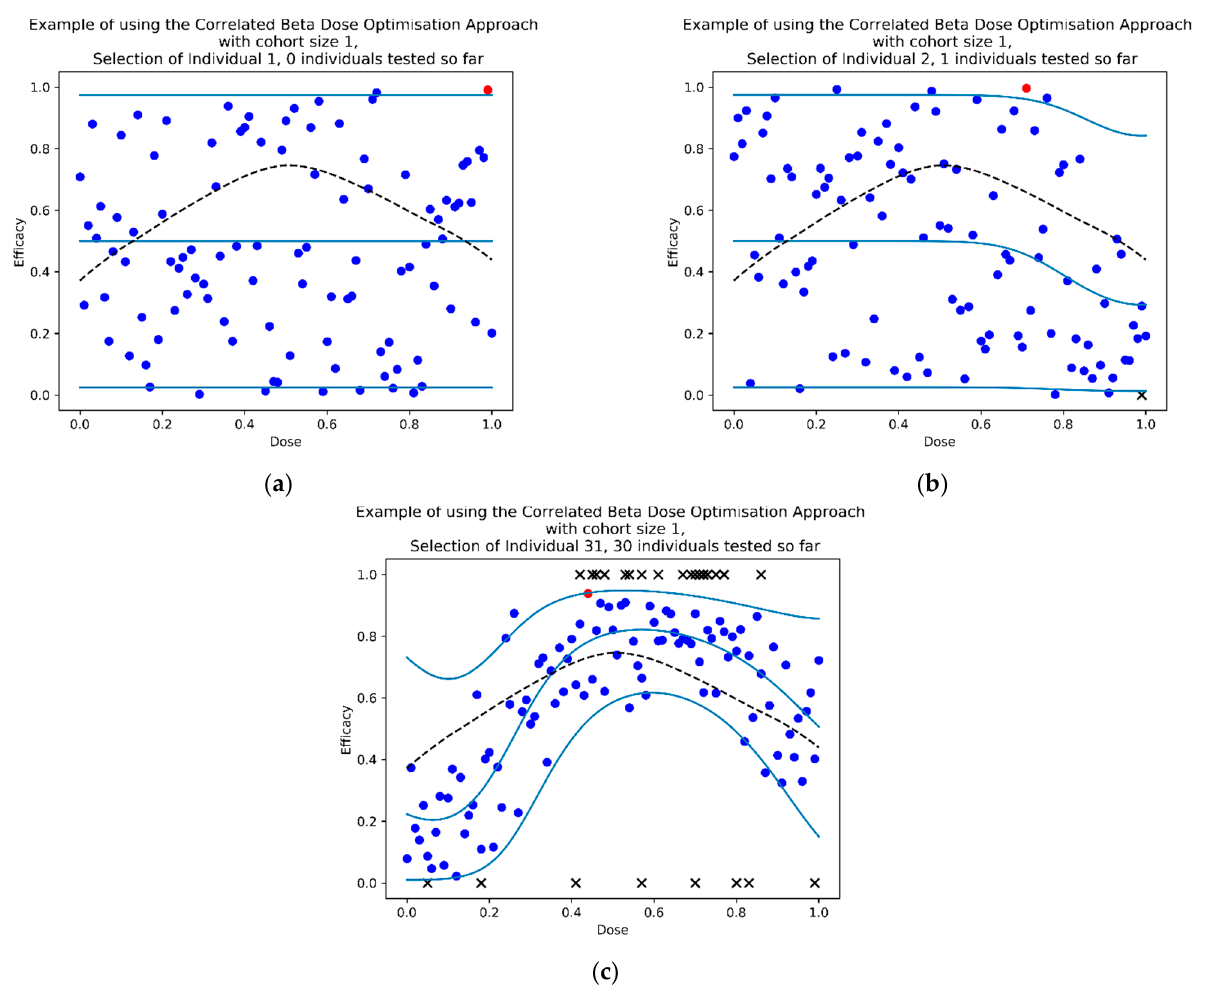
Figure 5. Three timepoints of an example dose-finding study using the CoBe DOA for selection of optimal dose (sampling cohort size c = 1) with the ‘Efficacy Maximisation’ utility function. At each time point, the dotted black line represents the true underlying dose-efficacy curve, and the black crosses represent observed data by that time point. The light blue lines represent the median and 95% confidence intervals (CI) for the predictions of the CCBP model, the blue dots represent efficacy prediction samples for each dose, the red dot represents the maximum of such samples which corresponds to the dose that would be selected to be tested next. At selection of individual 1 ( a ) efficacy samples varied uniformly between 0 and 1. After the first individual received a high dose and efficacy was not observed, ( b ) the median, 95%CI and samples for similar doses were lower when selecting the dose for individual 2. After the 30th individual ( c ), most samples had been selected near the true optimal and the model approximated the true curve (particularly near the predicted optimal dose).